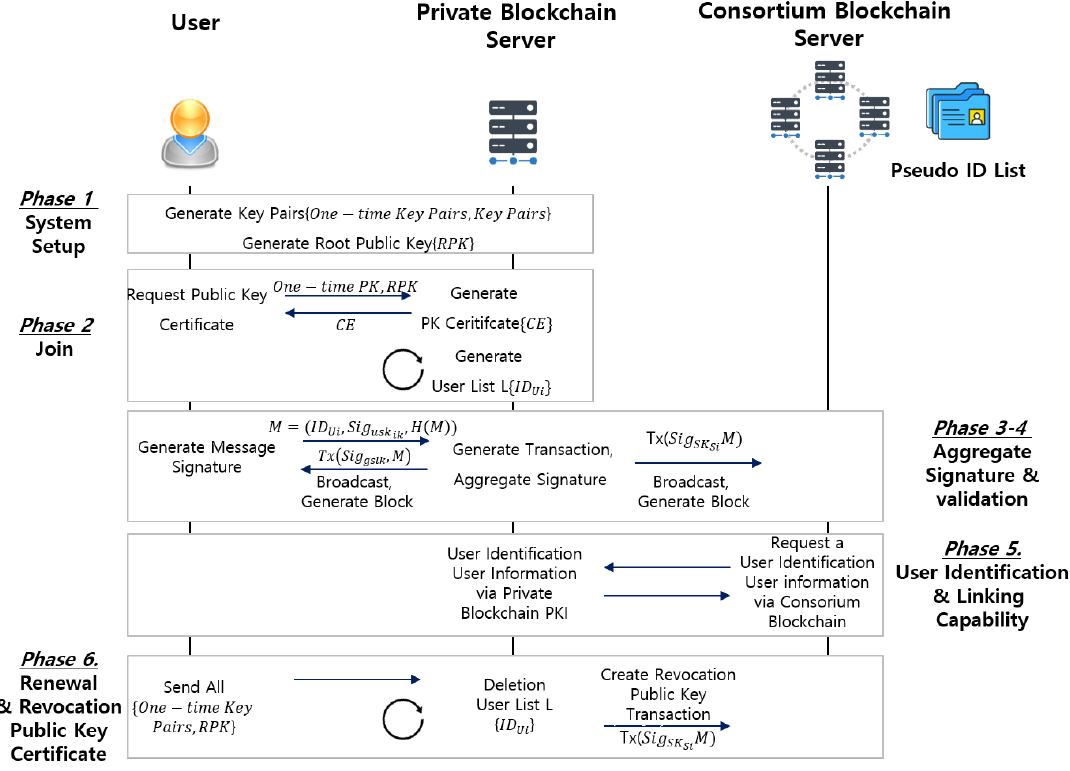
Figure 6. Scenarios of the proposed